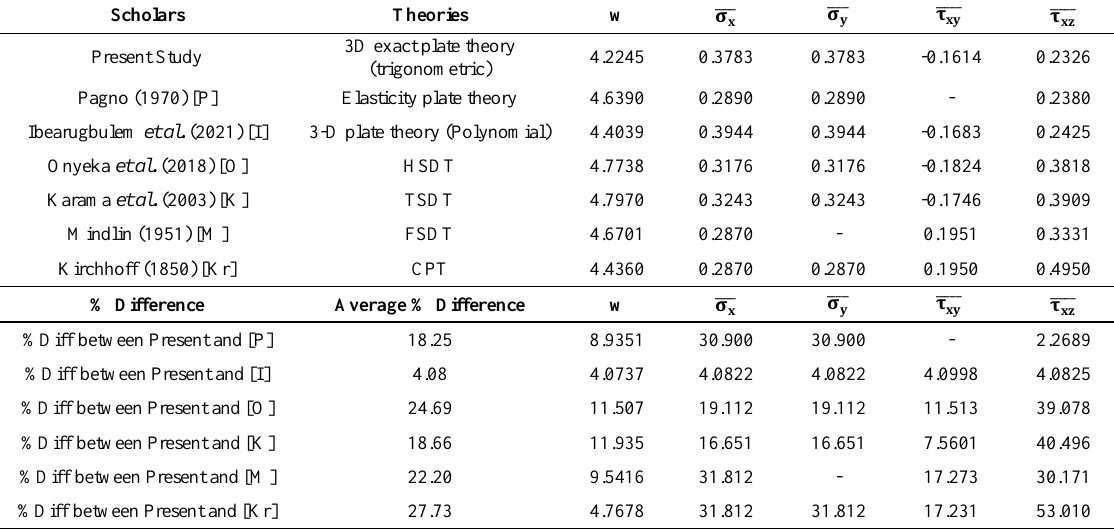
Table 3. Non dimensional forms of displacement and stresses of SSSS plate at aspect ratio b/a = 1.0 and a/t=10.